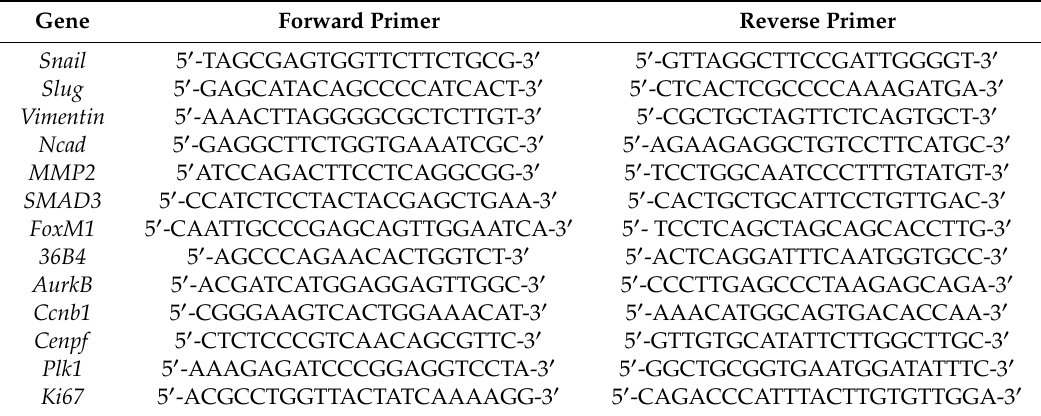
Table 1. Sequences of primers used in this